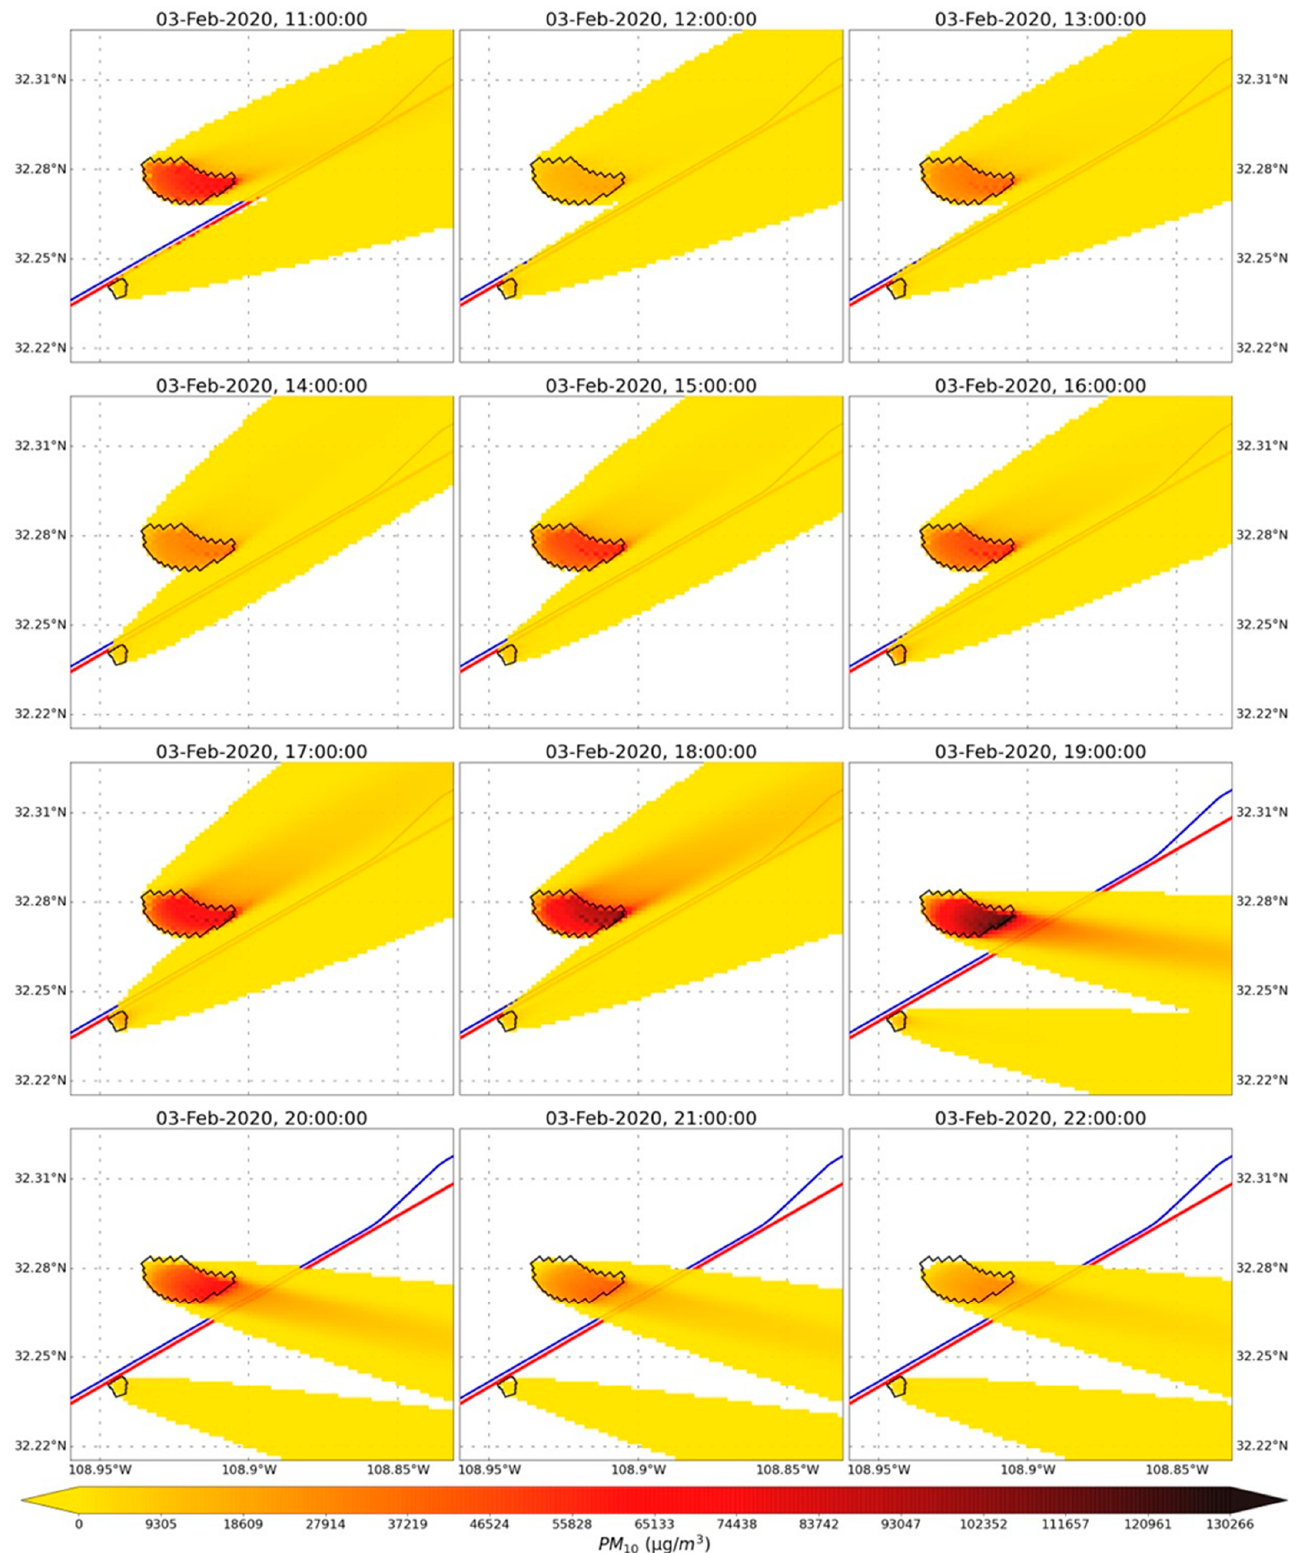
Figure 12. Hourly dispersion of PM 10 over Lordsburg Playa simulated by AERMOD for the dust event day of 3 February 2020. The two closed polygons represent the PM 10 sources. The red and blue lines represent I-10 and the Union Pacific Railroad, respectively.